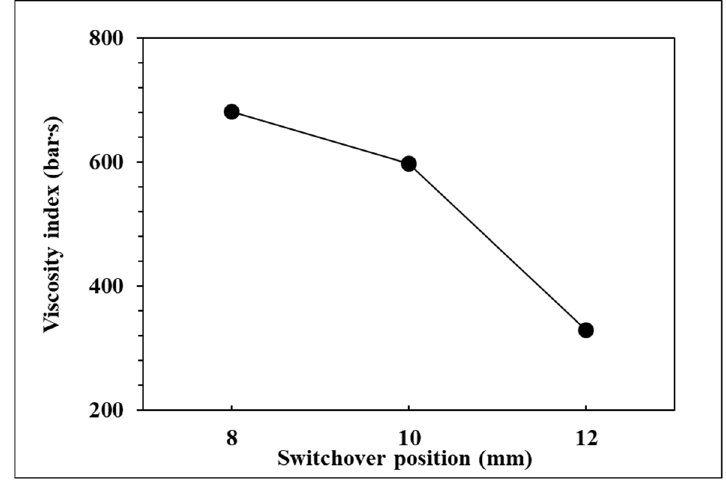
Figure 9. Relationship between viscosity index and switchover position .